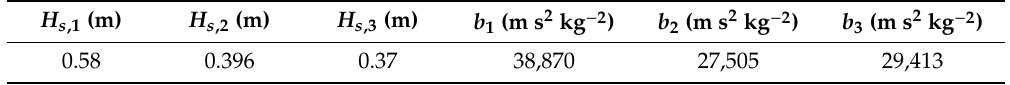
Table 2. Characteristic parameters of the pipeline network.